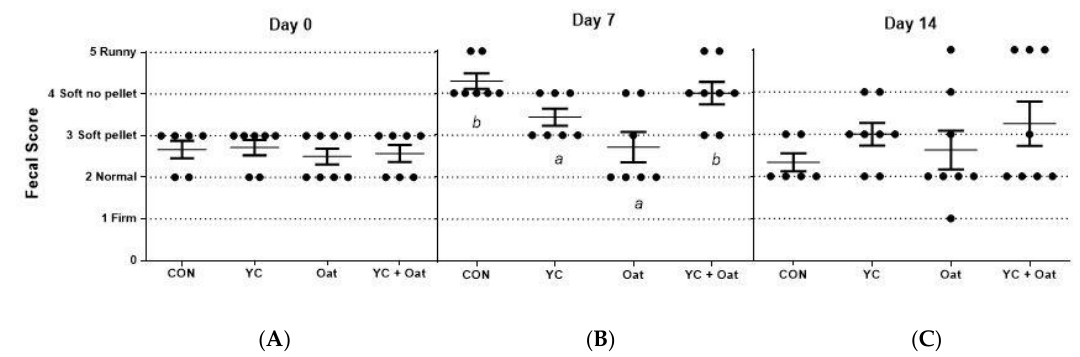
Figure 2. Fecal Scoring. Fecal samples were scored for diarrhea by seven participants blinded to treatments. Each visually scored the fecal matter using the following scoring criteria; (1) firm fecal pellets (2) normal pellets (3) soft pellets (4) soft no pellets but not runny (5) runny. The average scores ( A ) on day of weaning (day 0), ( B ), day 7 post-weaning, and ( C ) day 14 post-weaning are graphed. Data are an average of n = 7. Differences between letters a and b = p < 0.05.